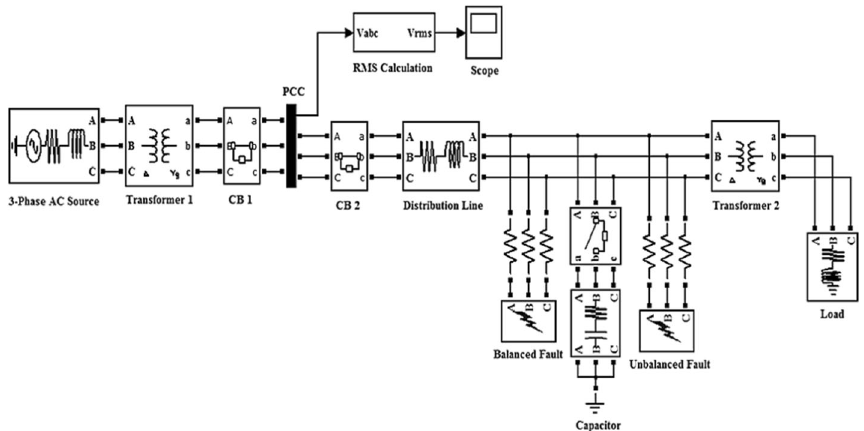
Fig. 8 Simulation circuit diagram of the system